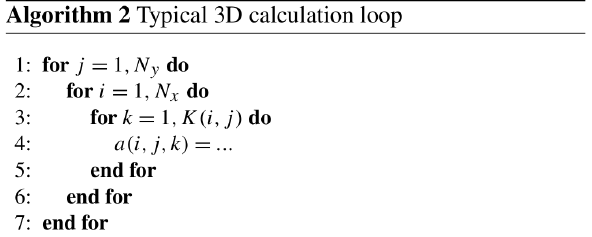
4 Organization of the calculations in non-parallel code Computations in the ocean and sea-ice components are per- formed using three-dimensional arrays, such as a(i,j,k) or b(i,j,m) , where i and j represent the horizontal grid indices, k represents the depth layer, and m represents the ice grada- tion. The differential operators are local: only neighboring grid nodes – that is, a(i ± 1 ,j ± 1 ,k) – are used. Typical differential operators in the ocean component are organized as shown in Algorithm 2, where N x = 500, N y = 500, and K(i,j) represents the number of depth layers. For land points, K(i,j) = 0 and K(i,j) ∈ [ 3 , 39 ] , with an approximate mean value of 12 for the remaining wet points; see Fig.